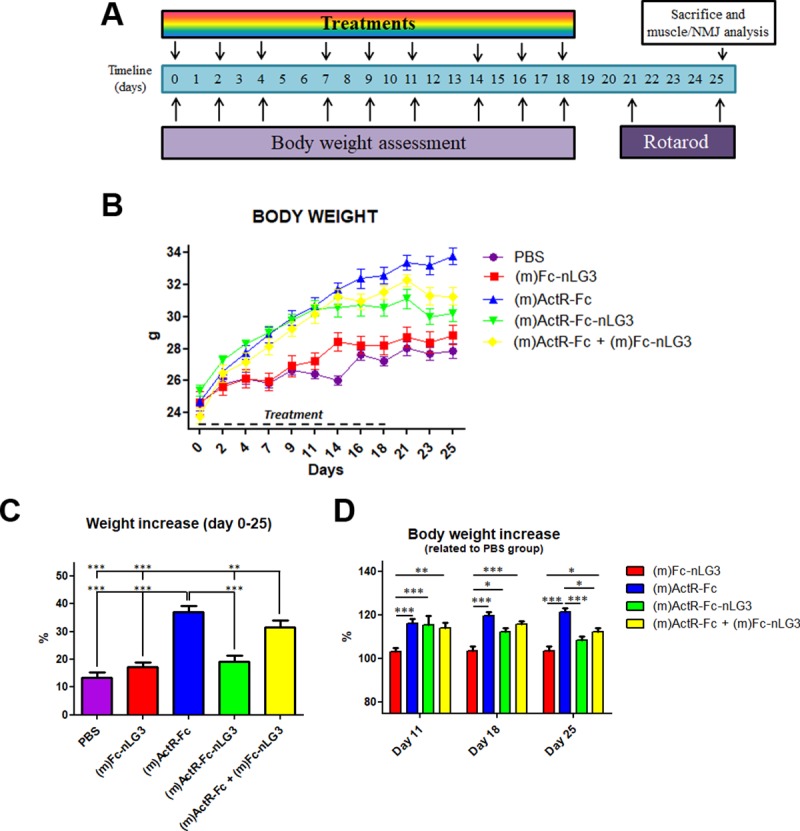
Evaluation of body weight.(A) Experimental timeline. (B) Weight increase displayed by PBS, (m)ActR-Fc, (m)Fc-nLG3, (m)ActR-Fc, (m)ActR-Fc-nLG3 and (m)ActR-Fc + (m)Fc-nLG3 treated groups. Two way ANOVA repeated measures: (m)ActR-Fc vs PBS, ***P < 0.001 from day 7 to day 21; (m)ActR-Fc + (m)Fc-nLG3 vs PBS, *P < 0.05 at day 7, **P < 0.01 at day 9, ***P < 0.001 from day 11 to day 21 (m)ActR-Fc-nLG3 vs PBS, *P < 0.05 at day 4, 23 and 25; ***P<0.001 from day 7 to day 21. (C) Weight increase between day 0 and day 25 expressed as a percentage; one way ANOVA, Bonferroni post hoc test **P < 0.01, ***P<0.001. (D) BW increase reached at day 11, day 18 and day 25, expressed by attributing to PBS group the value of 100% (two way ANOVA, Bonferroni post hoc test *P<0.05, **P < 0.01, ***P<0.001).